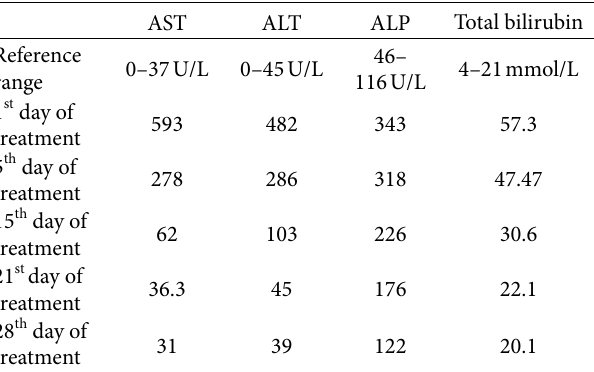
Table 1: Liver enzymes improved with the